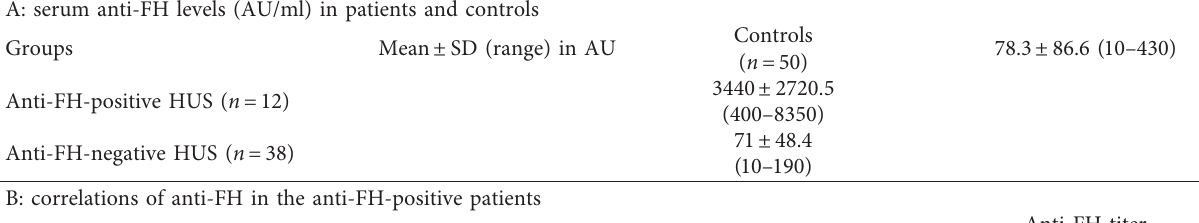
Table 3: Serum levels and correlations of anti-FH.